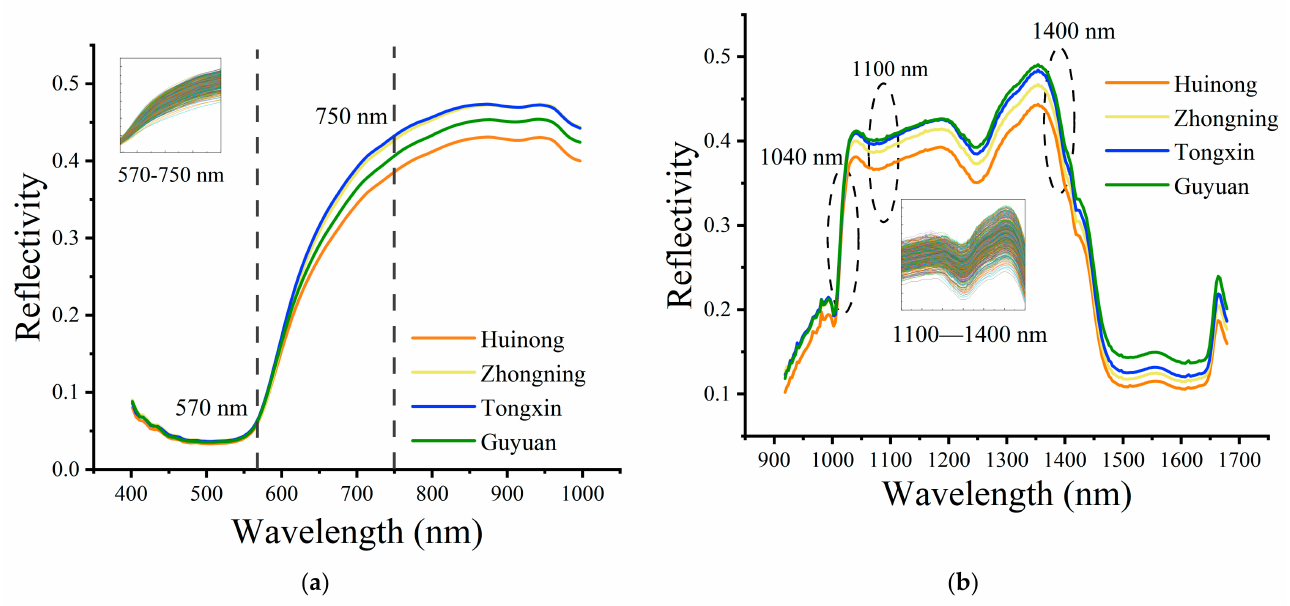
Figure 7. Vis-NIR ( a ) and NIR ( b ) average spectral curve of different wolfberry production areas in